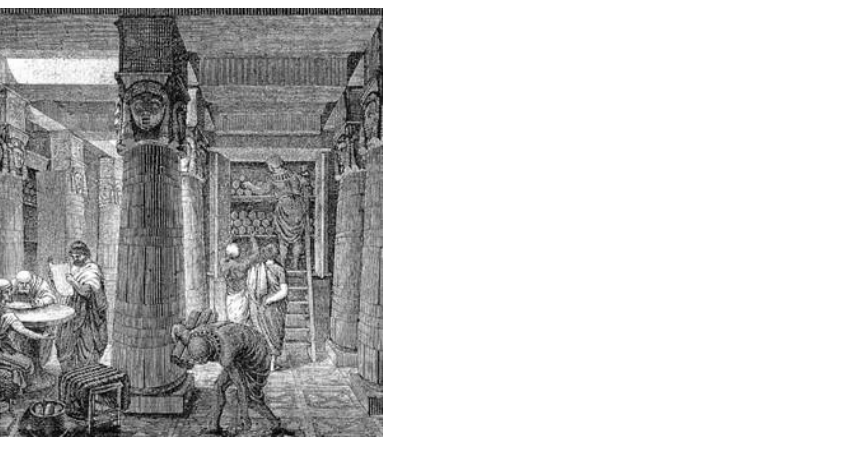
Figure 9. The Library of Alexandria based on some archaeological evidence [7].